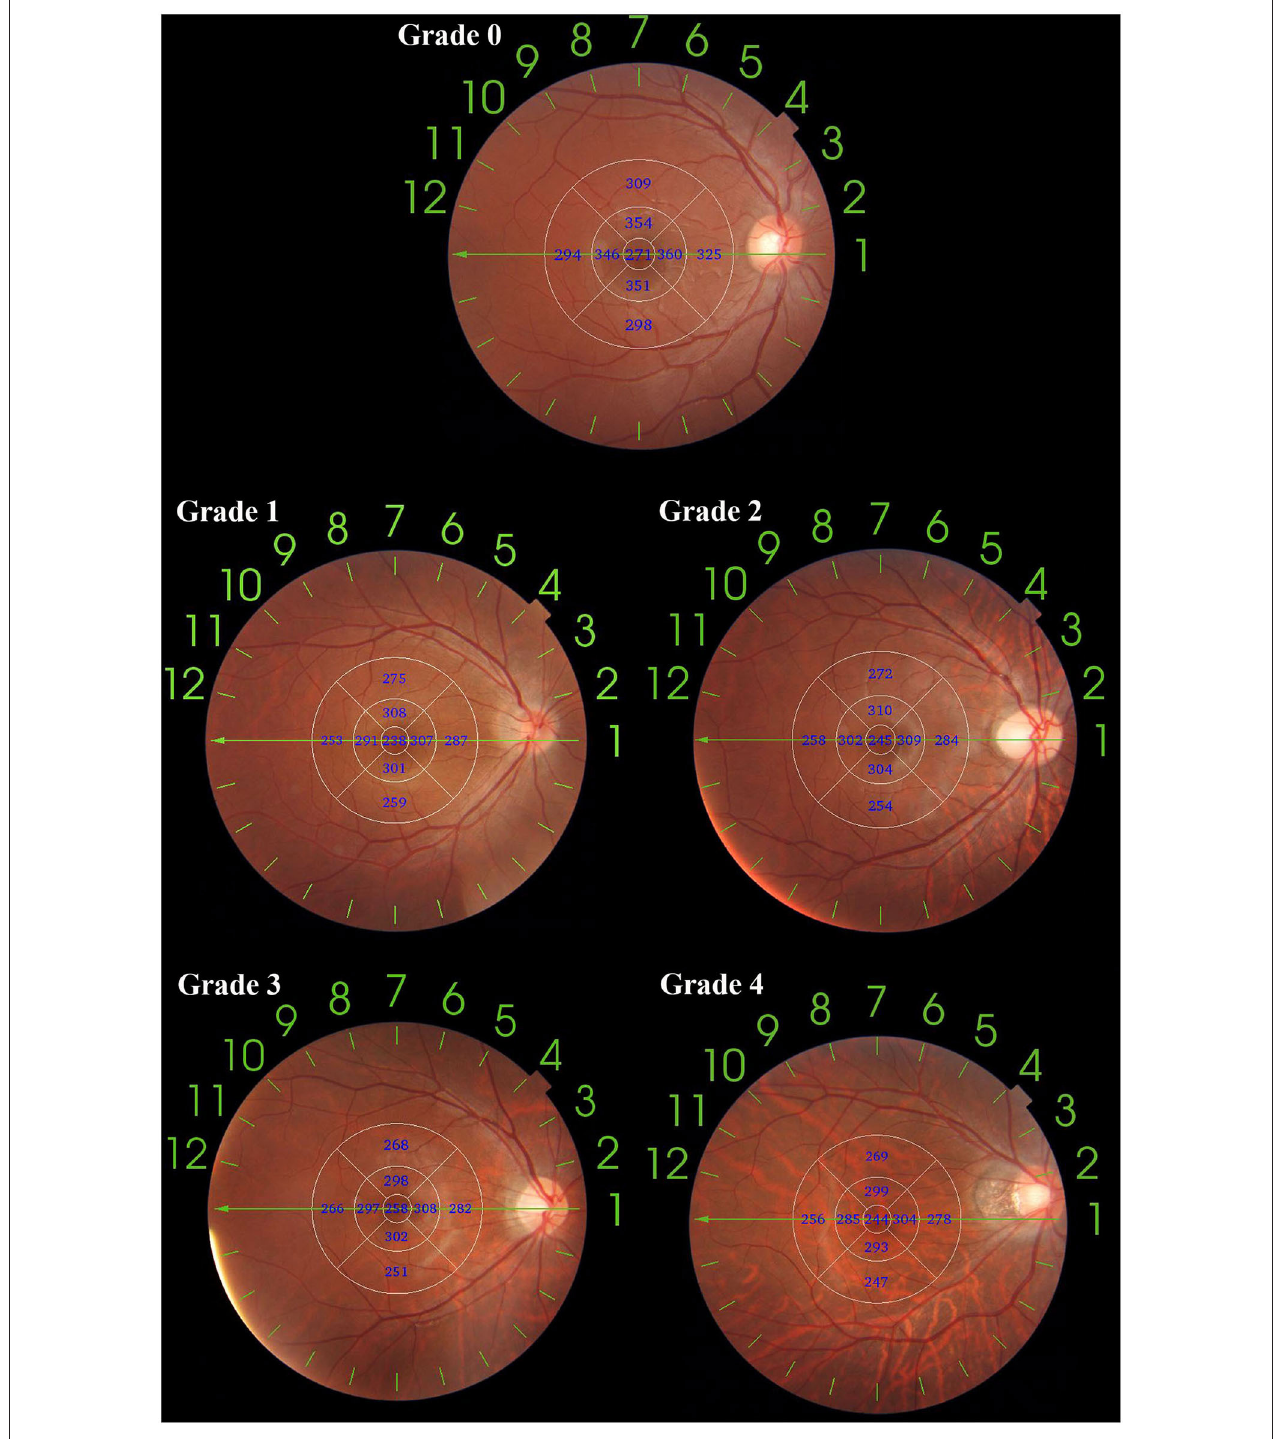
FIGURE 1 | An application of ETDRS grid on fundus tessellation grading. The diameter of center, inner and outer circle are 1, 3, and 6mm. Eyes with no fundus tessellation were graded as Grade 0; eyes with fundus tessellation without involving the outer circle were graded as Grade 1; eyes with fundus tessellation involving the outer circle of were graded as Grade 2; eyes with fundus tessellation involving the inner circle were graded as Grade 3; eyes with fundus tessellation involving the center circle were graded as Grade 4.